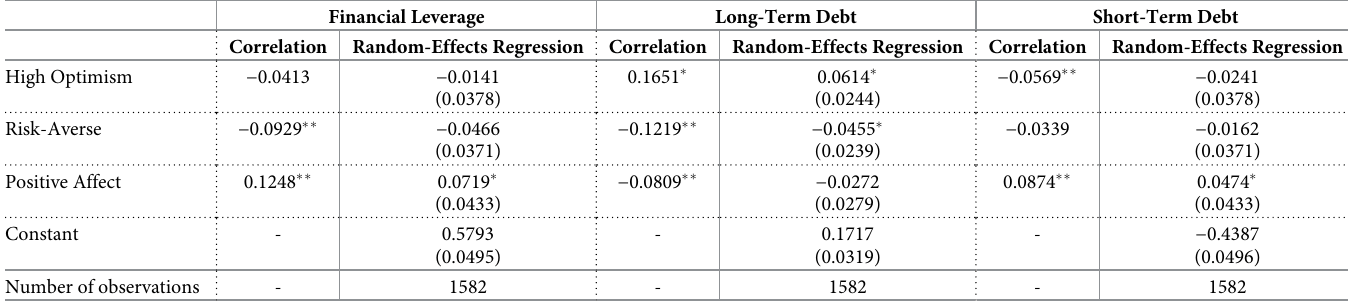
Table 3. Correlation and random-effects regression